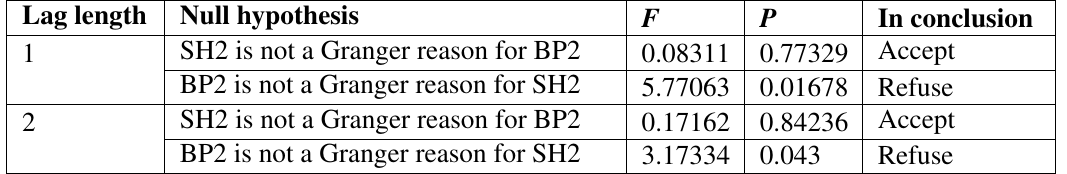
Table 2 SH2 and BP2Granger causality test